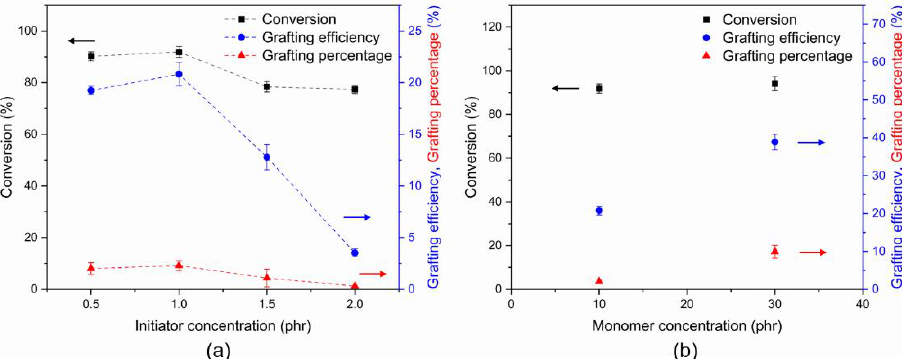
Figure 3. ( a ) Effect of initiator contents; ( b ) effect of monomer contents on the monomer conversion, grafting efficiency and grafting percentage.